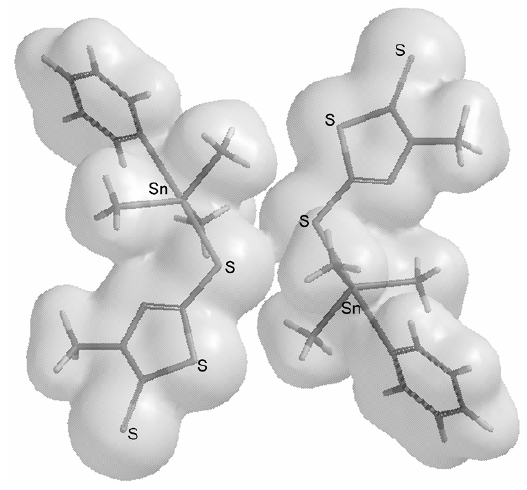
Figure 2. Electron density computed for a truncated version of the experimental structure shown in Fig. 1 (Isovalue=0.008; BP86/6-31G**, single-point calculation on crystal structure Fig. 3 illustrates the one frontier molecular orbital which was found to correlate with the electron density in Fig. 2, extending between the two sulfur atoms. It can be seen that this molecular orbital has strong contributions from the p orbitals belonging to the two sulfur atoms; these p orbitals thus appear to engage in a π-type interaction. One may therefore speculate that it is this molecular orbital (or the respective p-p orbital interaction)